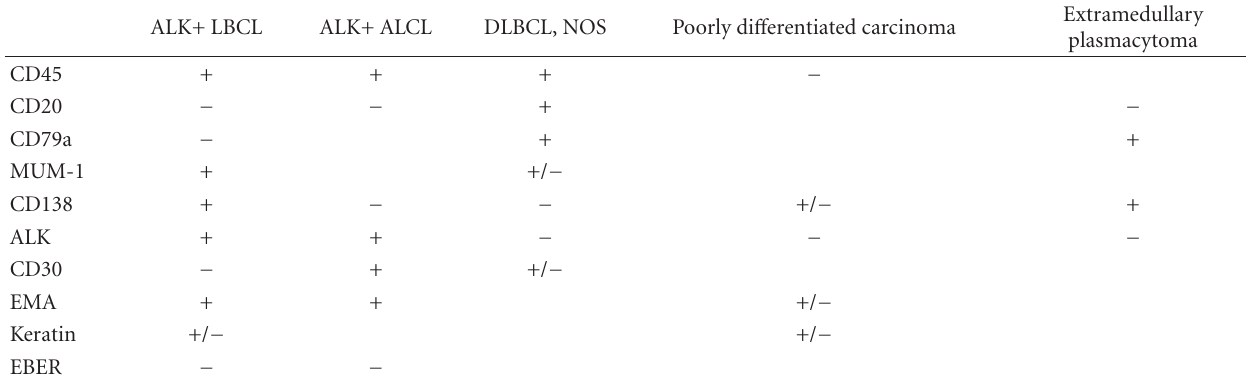
Table 1: Di ff erential diagnosis of ALK+ LBCL and predominant staining patterns with several antibodies. This table summarizes the predominant staining patterns for these entities, with the understanding that exceptional cases have been reported. Typically, ALK+ LBCL demonstrates a postgerminal center phenotype and is negative for CD30. Rare cases expressing CD20, CD79a, or CD30 have been reported